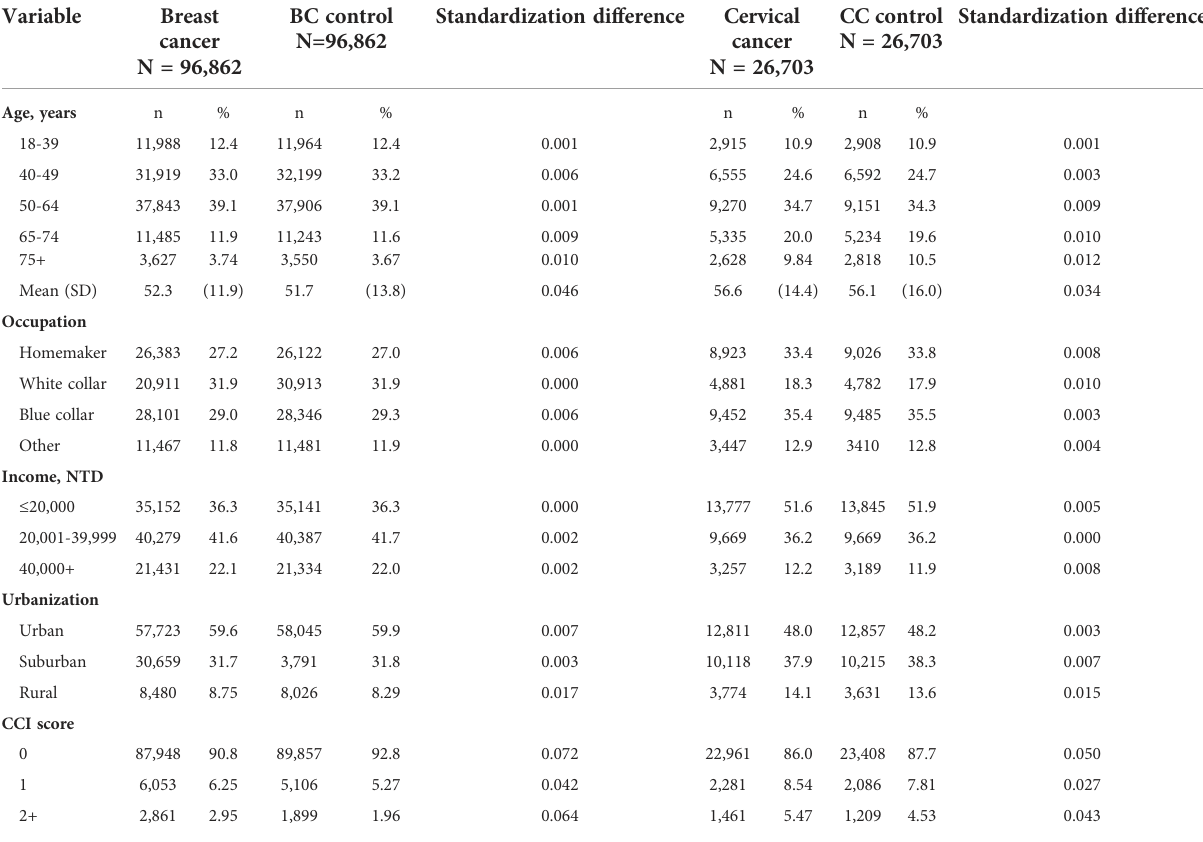
TABLE 1 Distributions of baseline characteristics compared between breast cancer cohort and BC control cohort and between cervical cancer cohort and CC control cohort. Variable Breast BC control cancer